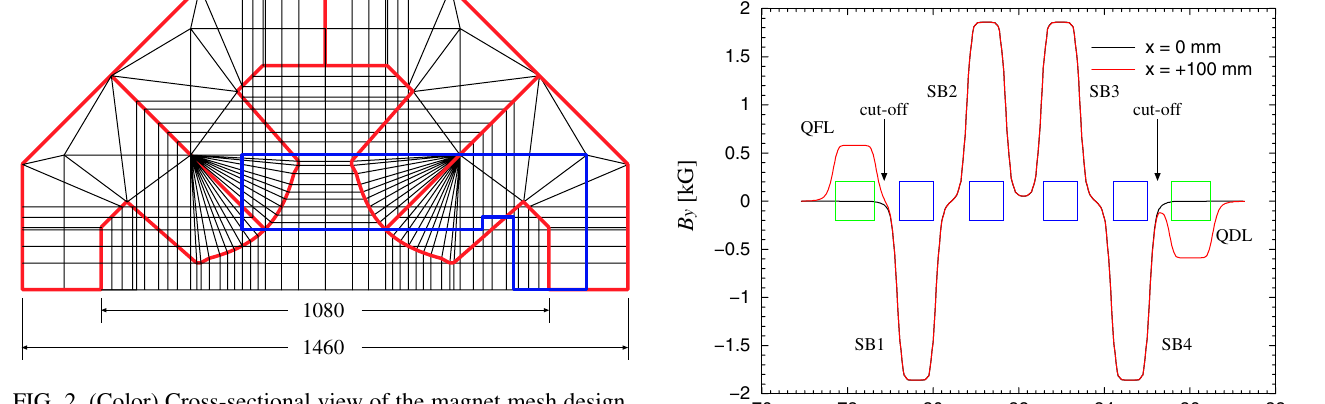
FIG. 2. (Color) Cross-sectional view of the magnet mesh design for the complex dipole and quadrupole system. The yoke shape of the dipole and quadrupole magnets are shown by blue and red lines, respectively. Black lines show the broad blocks of analysis. FIG. 3. (Color) B